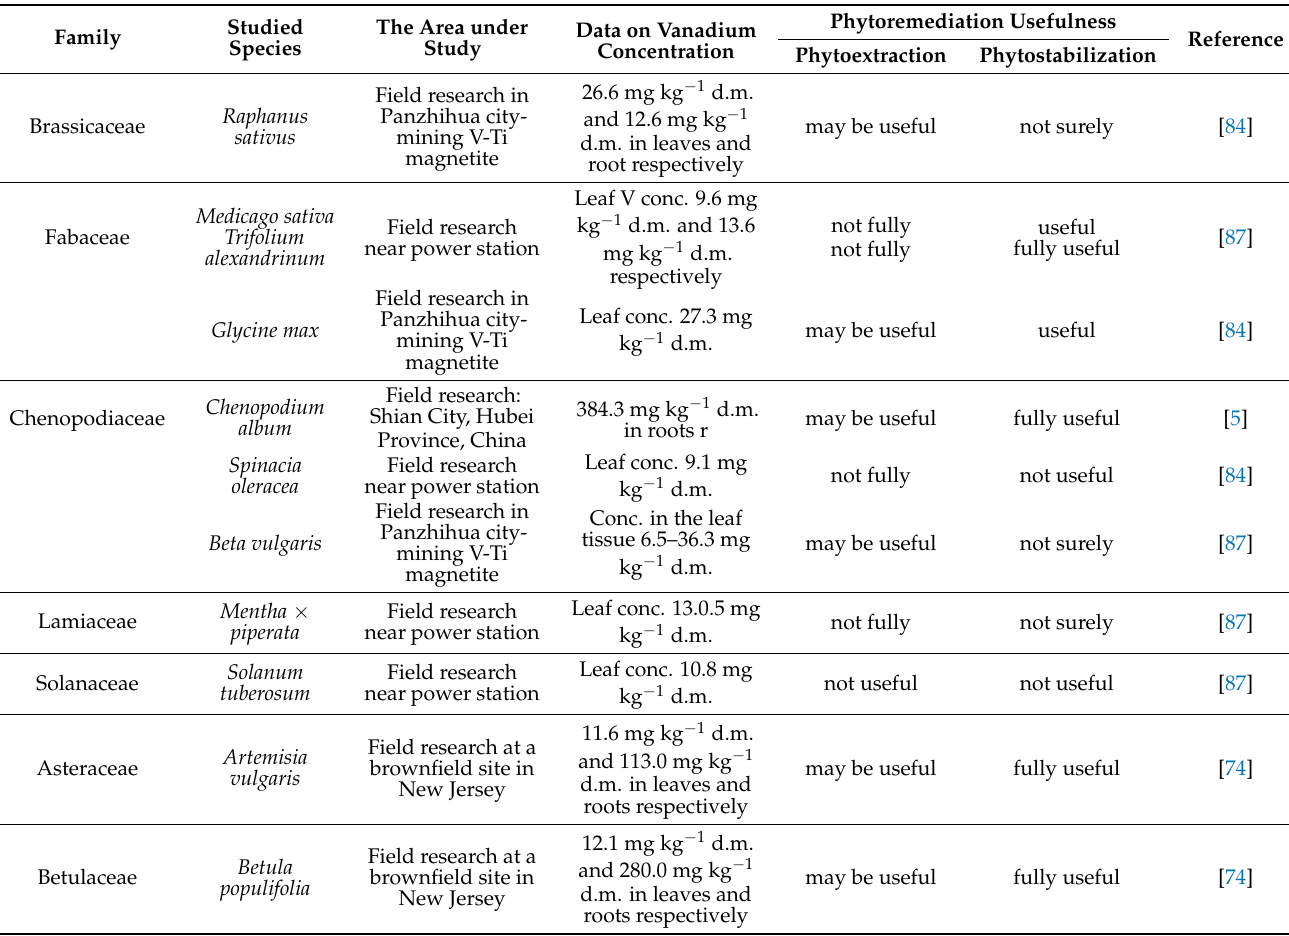
Table 1. The assessment of the potential of the so far studied species representing various taxonomic origin for use during the reclamation schemes of the polluted substrate or bottom sediments from excessive vanadium content.